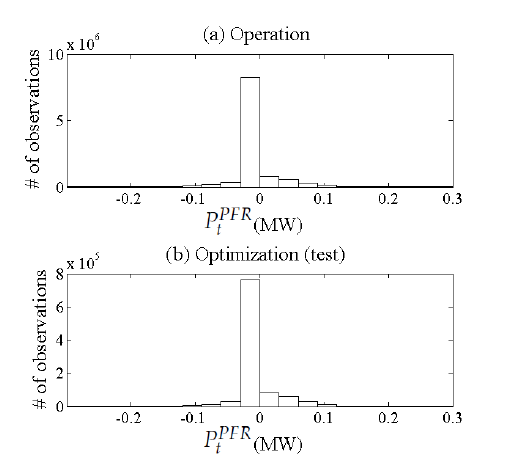
Figure 5. P PFR distribution: ( a ) for the complete dataset; ( b ) for the optimization dataset. t